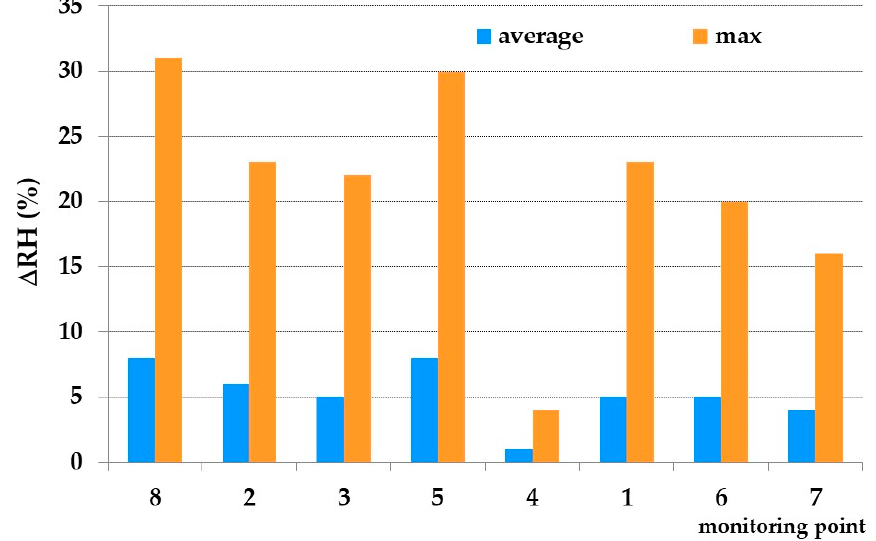
Figure 10. Average and highest RH daily variation (for point 2 only one value was reported, as the values measured at the two heights were the same).